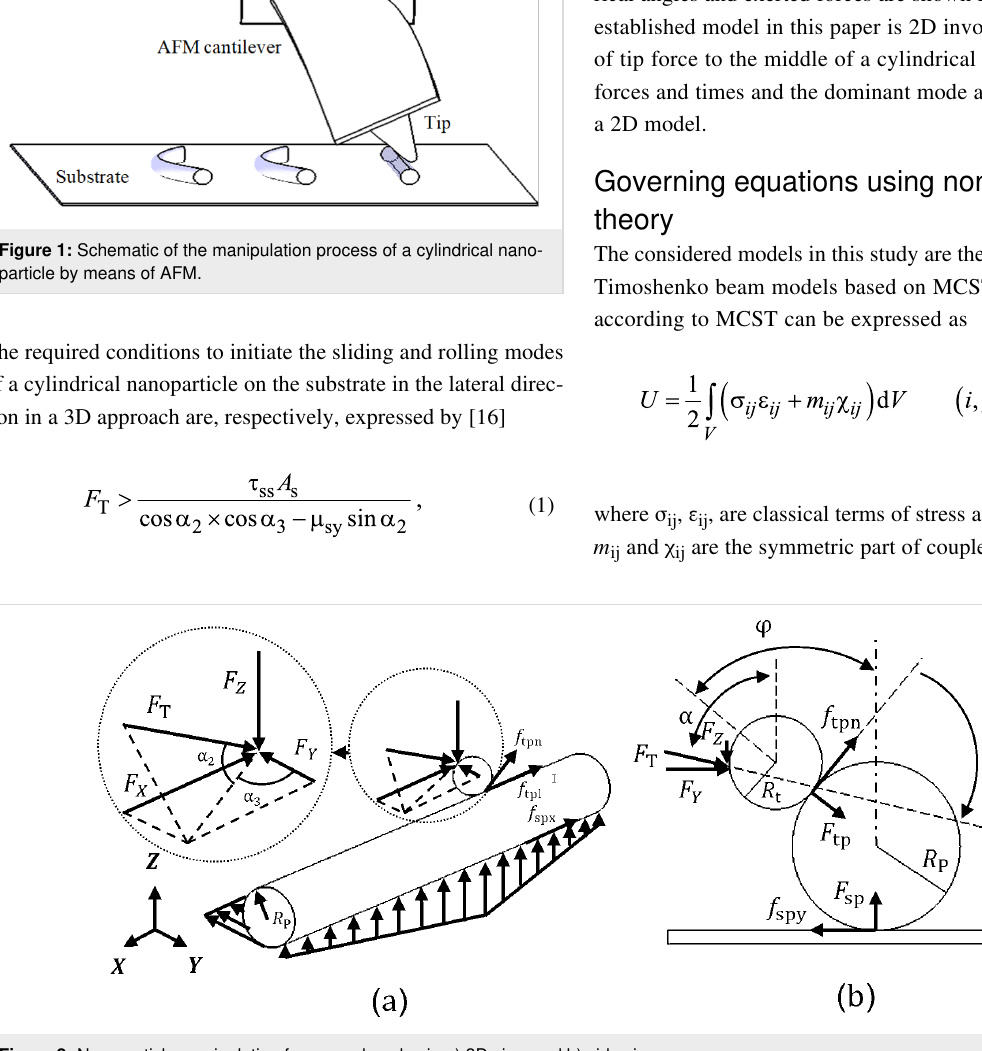
Figure 2: Nanoparticle manipulation forces and angles in a) 3D view and b) side view.